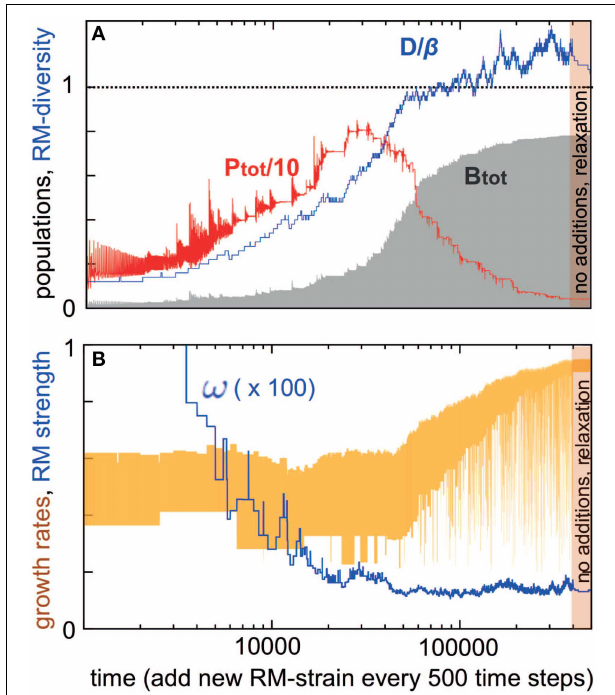
FIGURE 3 | Development of a system where bacterial strains with new RM systems are added sequentially (500 time steps). For the new strain, β i 50 , η i 1 , δ i 0 . 2 , ω i is chosen from [ 0 . 0001 : 1 ] , and γ i from [ 0 . 2 : 1 ] . = = = The bacterial dilution rate is fixed at α 0 . 2 . The simulation starts with few = strains, and at the end we let the simulation run for 100000 time units without adding new bacterial strains. (A) Shows diversity/burst-size (blue), total bacterial population (gray) and total phage population (red) vs. time. (B) Shows RM strengths (blue) and bacterial growth rates (yellow) vs.